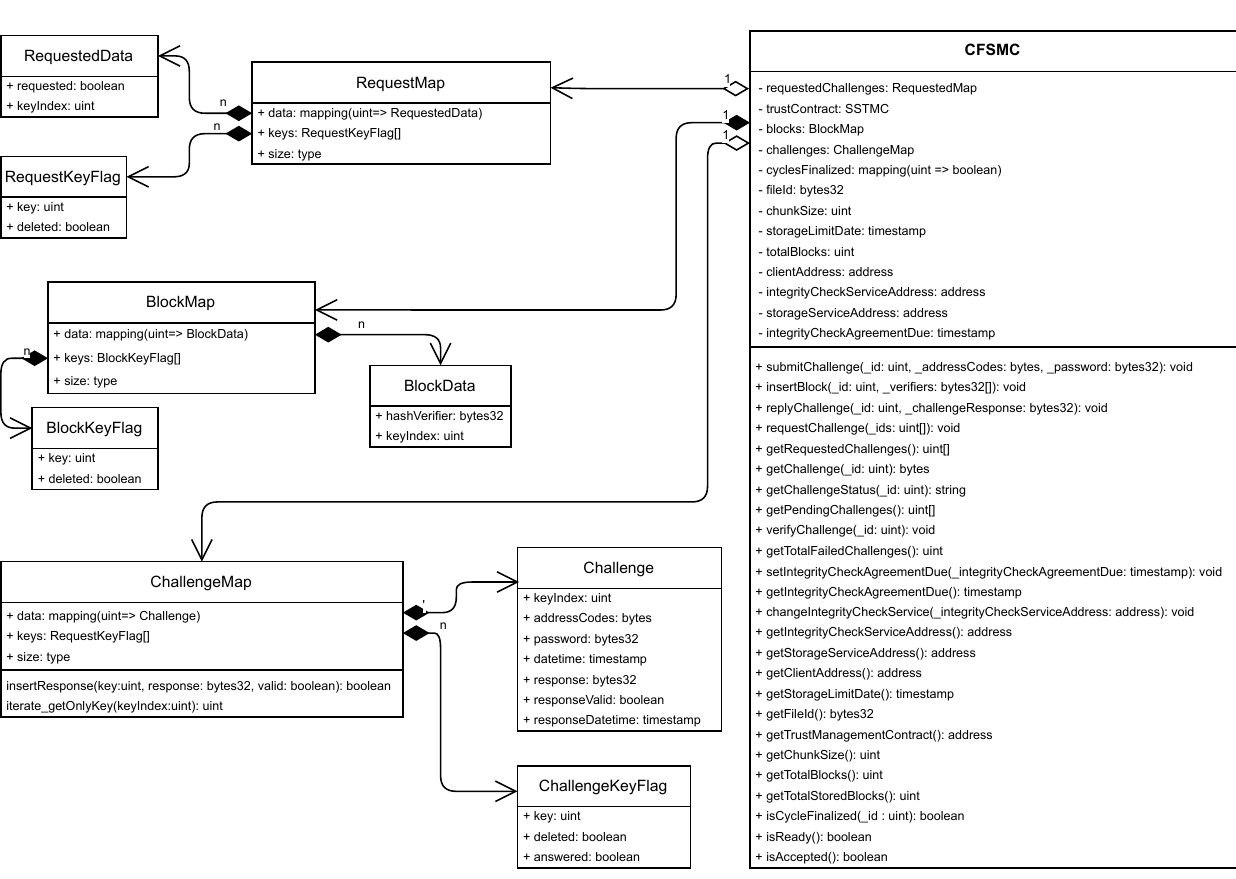
Figure 3. Class diagram of the CFSMC. Table 3. Description of the attributes present in the